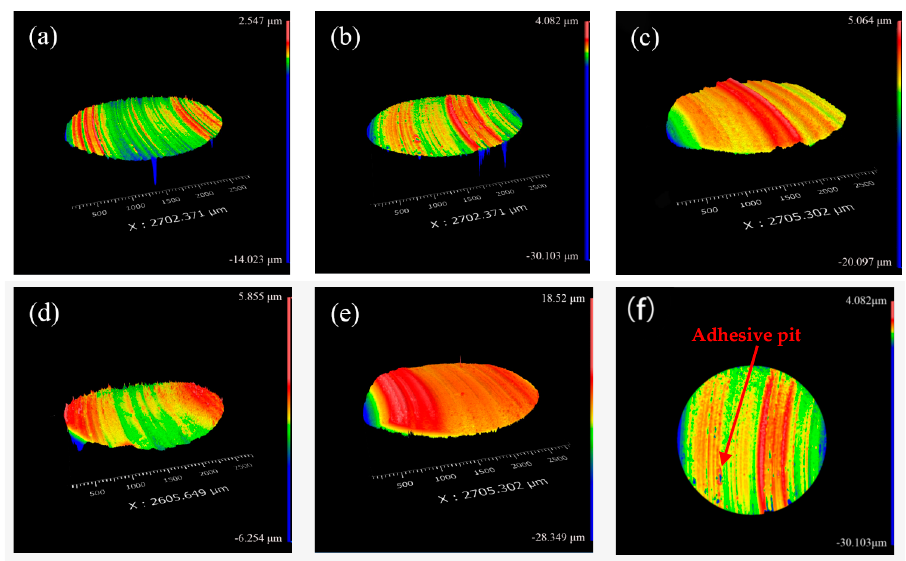
Figure 8. Three-dimensional profiles after wear of grinding pins prepared using the same process and different Cr 3 C 2 content: ( a ) 0 wt.%, ( b , f ) 5 wt.%, ( c ) 15 wt.%, ( d ) 25 wt.%, and ( e ) 35 wt.%.